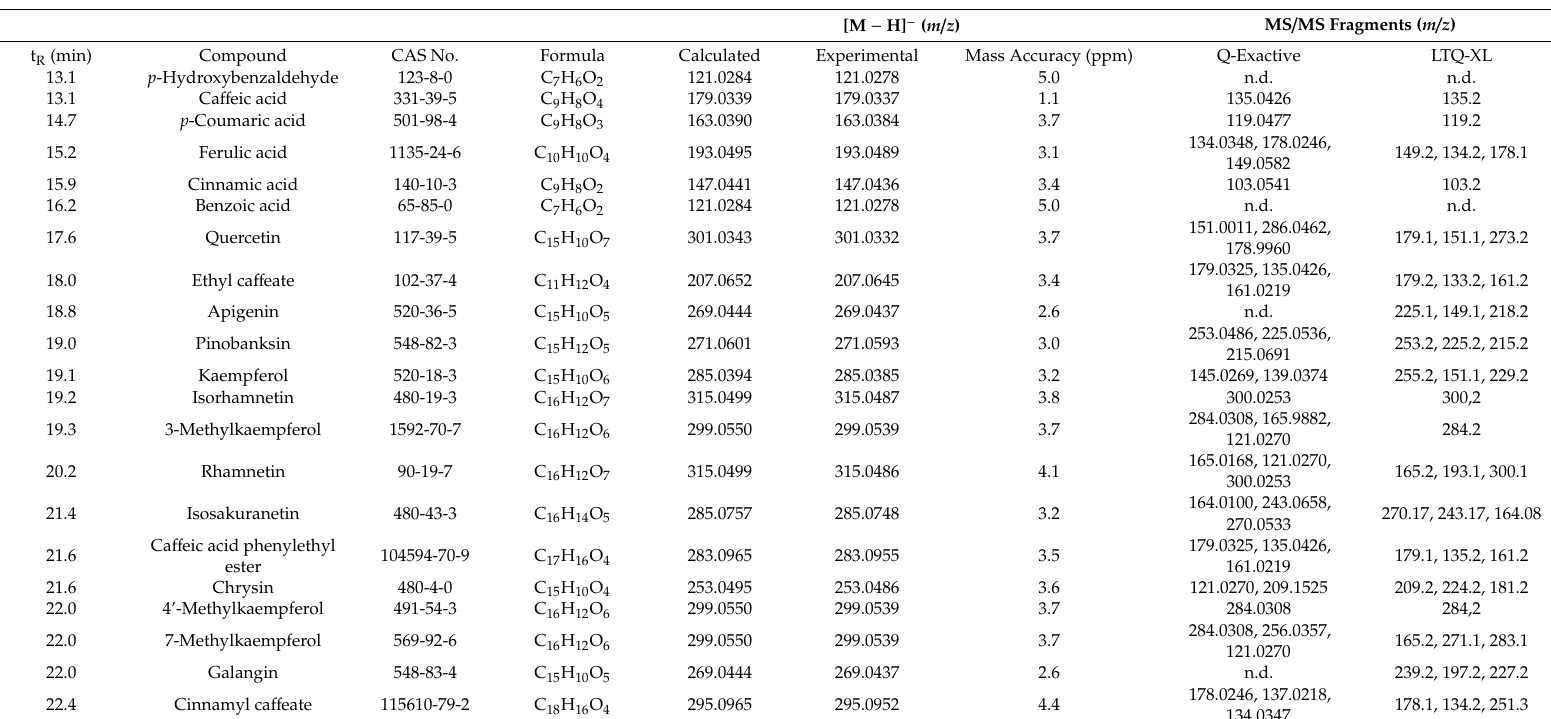
Table 3. A list of standard compounds identified in extracts of propolis from Eastern Canada (South-East New Brunswick) by LC-MS / MS: All identifications in this table were confirmed with analytical